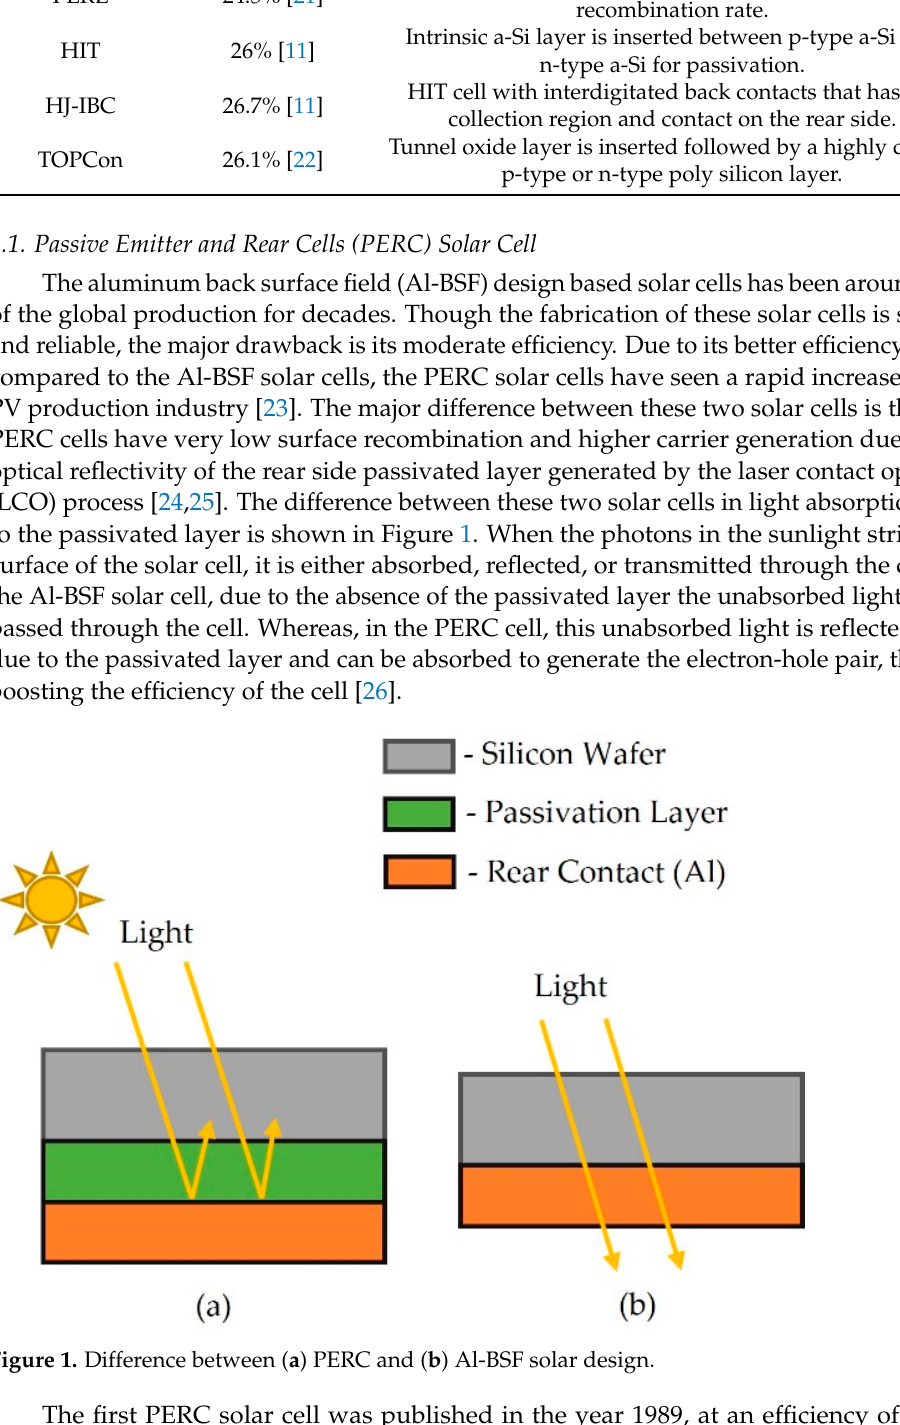
Table 1. Highly Efficient silicon based single-junction solar cells.